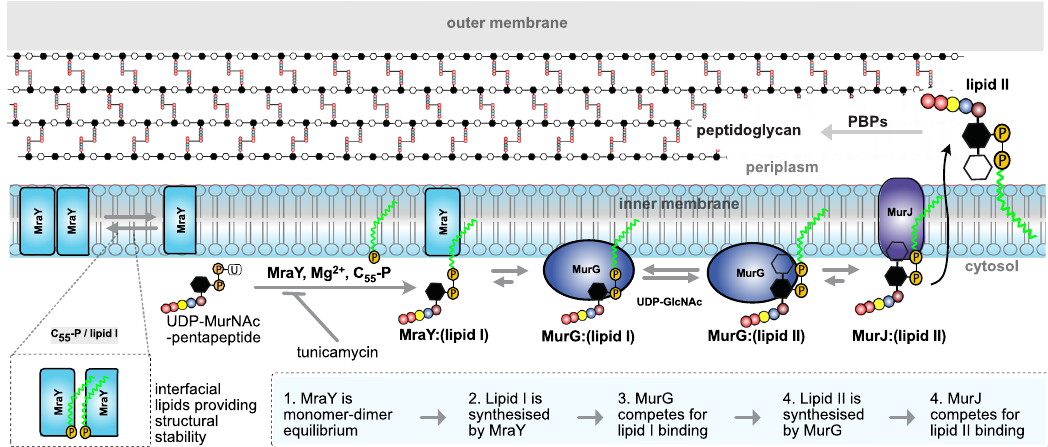
Fig. 6 Insights into key steps of peptidoglycan biosynthesis from native MS. MraY exists in a monomer-dimer equilibrium with dimerisation favoured in the presence of endogenous C 55 -P and lipid I. MraY binds lipid substrates to stabilise its dimeric state. Synthesis of lipid I via MraY can be effected in vitro from C 55 -P and UDP-MurNAc-pentapeptide, and a change in mass con fi rms that endogenous lipid I was displaced by its biosynthetic counterpart. Tunicamycin binds to MraY and inhibits lipid I formation. MurG binds to lipid I with a higher af fi nity than MraY, to drive the passage of lipid I along the pathway, and forms lipid II in the presence of UDP-GlcNAc. The fl ippase MurJ then outcompetes MurG and MraY to bind lipid II, forming the binary 1:1 complex. Lipid II is fl ipped into the periplasm where its polar disaccharide peptide head is incorporated into the peptidoglycan